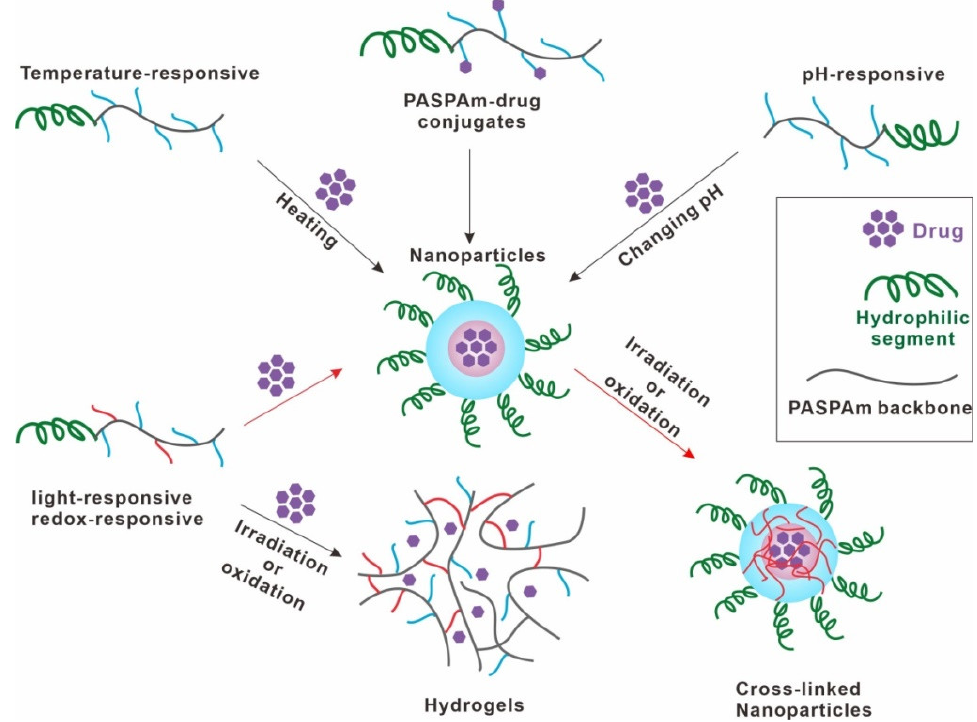
Figure 3. Typical drug loading procedures of various stimuli-responsive PASPAm derivatives.